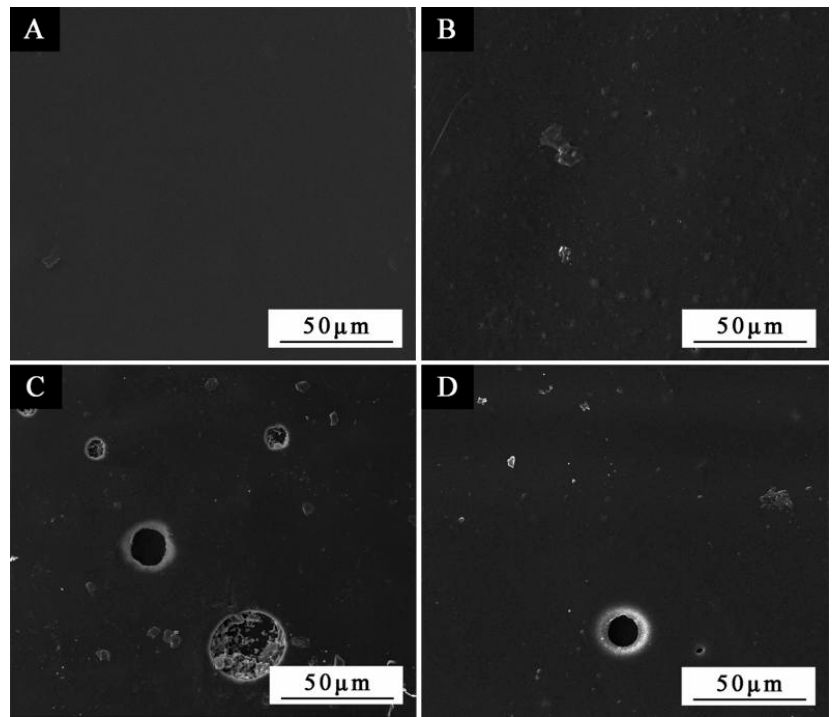
Figure 14. SEM of the paint film with and without microcapsules before and after aging in the ZN ultraviolet weather resistance test: before aging ( A ) without, ( B ) with microcapsules; after aging ( C ) without, ( D ) with microcapsules.